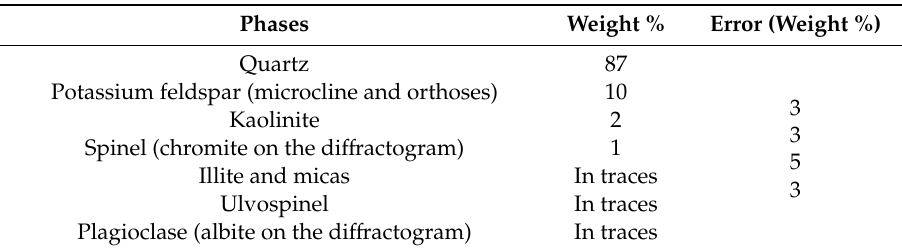
Table 4. Mineralogy of sample ONERA-ESA_ArabiaPICS2_PICSAND_SPL5. Phases